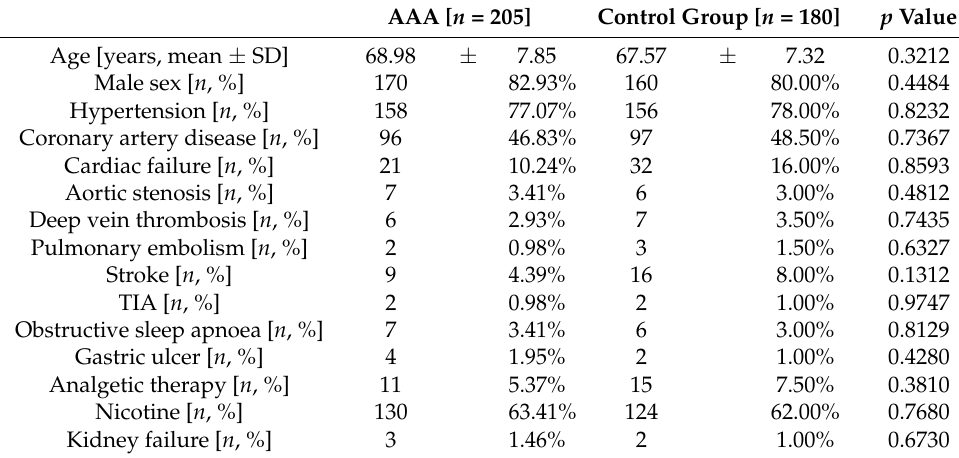
Table 1. Clinical characteristics of the study and control